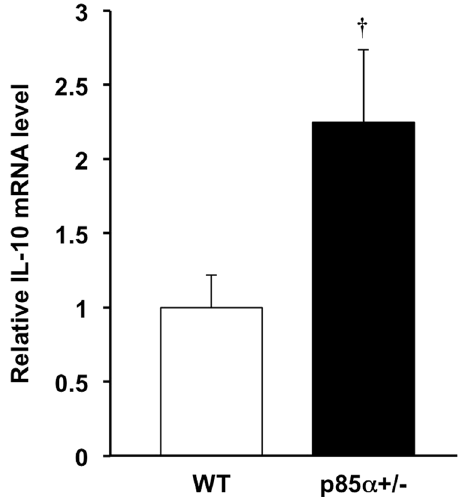
Figure 5. Intestinal macrophages from p85 α+ / − normal mice express a high level of IL-10 mRNA. F4/80 + macrophages were isolated from the colons of normal WT or p85 α+ / − mice using the IMag system. F4/80 + macrophages were stimulated with LPS (100 ng/ml) for 4 h. The data are presented as the mean ± SE of 4 independent experiments. † p < 0.05, compared with WT